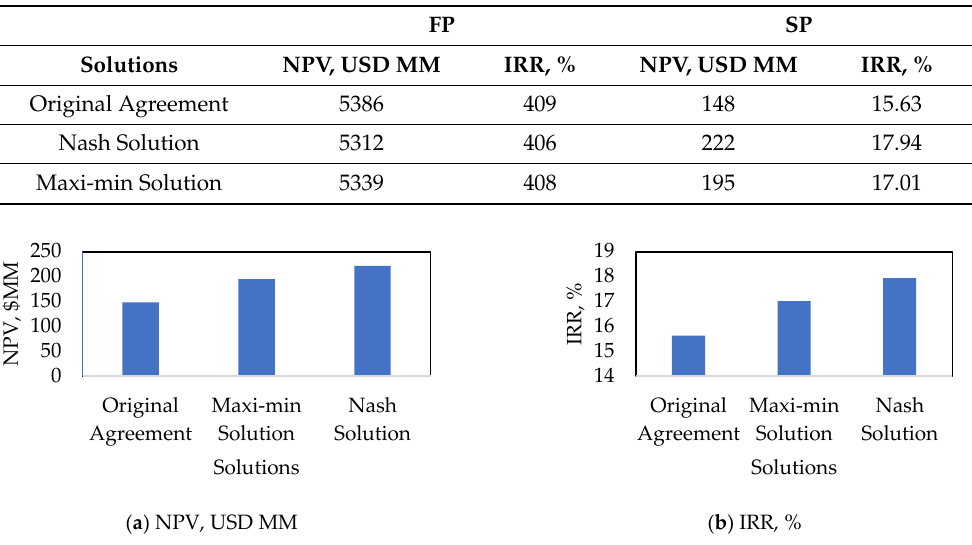
Figure 3. The SP’s NPVs and IRRs of the original agreement and the optimization solutions of the Maxi-min and Nash solutions.